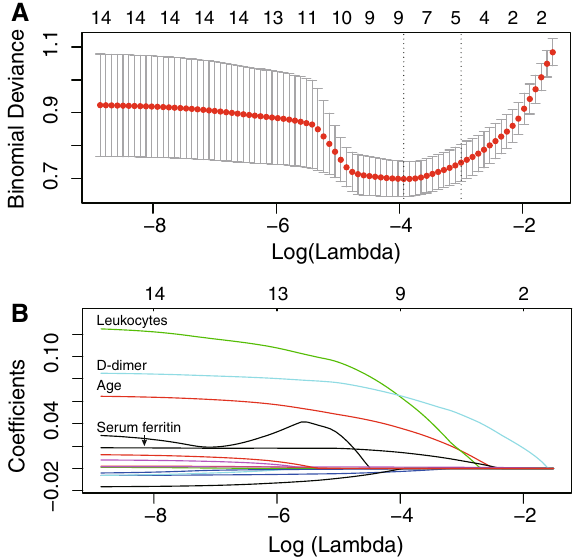
Figure 3. Feature selection using the LASSO binary regression model to identify independent factors of cardiac injury. ( A ) Tuning parameter (λ) selection in the LASSO model used tenfold cross-validation via minimum criteria. The binomial deviance was plotted versus log (λ). Dotted vertical lines were drawn at the optimal values by using minimum criteria and the 1 standard error (1-SE criteria). ( B ) LASSO coefficient profiles of the 15 features. A coefficient profile plot was produced against the log(λ) sequence. Dotted vertical line was drawn at the optimal λ at minimum criteria and 1 standard error (1-SE criteria). The model at 1-SE criteria was selected as the final model with 4 nonzero coefficients including age, leukocytes, D-dimer, and serum ferritin. LASSO, least absolute shrinkage and selection operator.